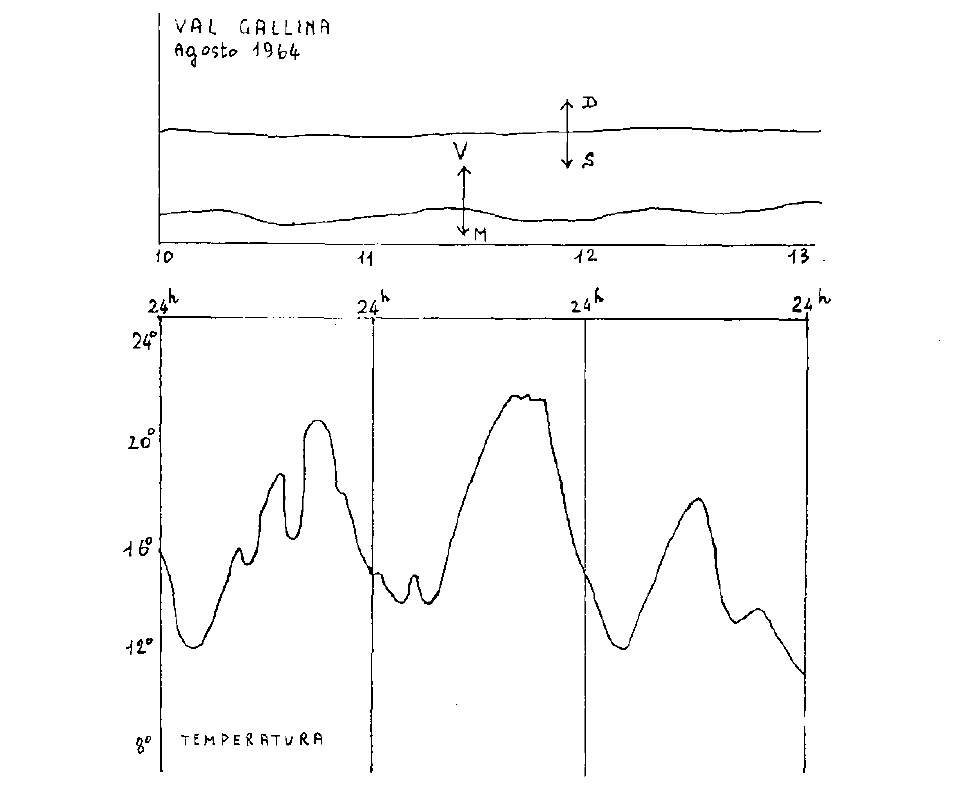
Fig. 17 - Un esempio di confronto fra dati clinograflci e dati di tempera- tura ed invaso ottenuti presso la postazione di Val Gallina, a bacino vuoto. 5 mm =